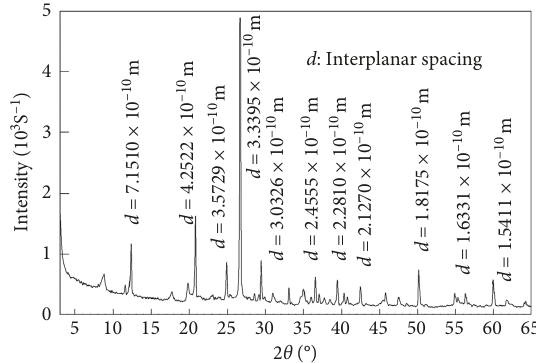
Figure 2: X-ray diffraction spectrum of carbonaceous mudstone.